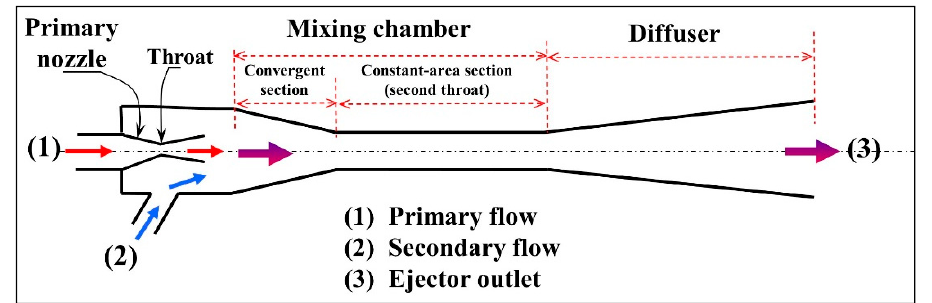
Figure 1. Schematic representation of the ejector geometry.